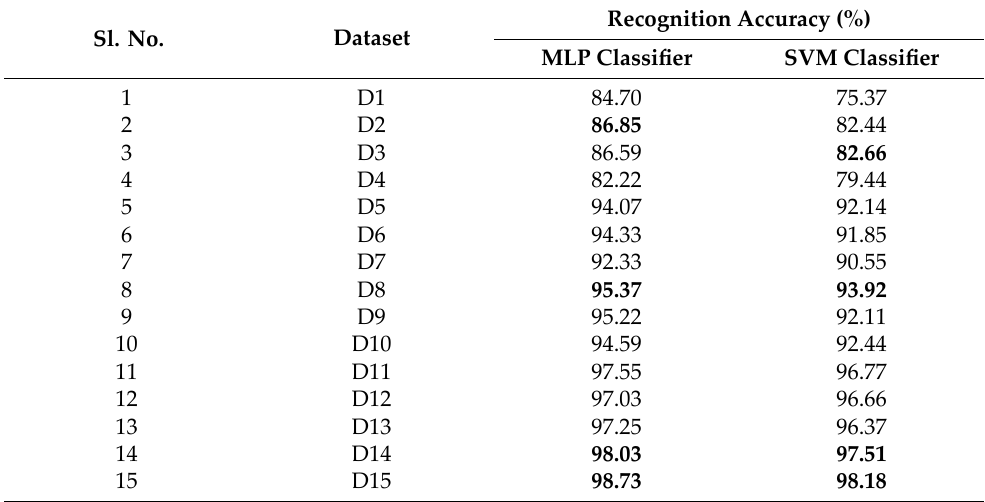
Table 6. Recognition accuracy achieved by the model from proposed feature‑extraction schemes. Sl. No.